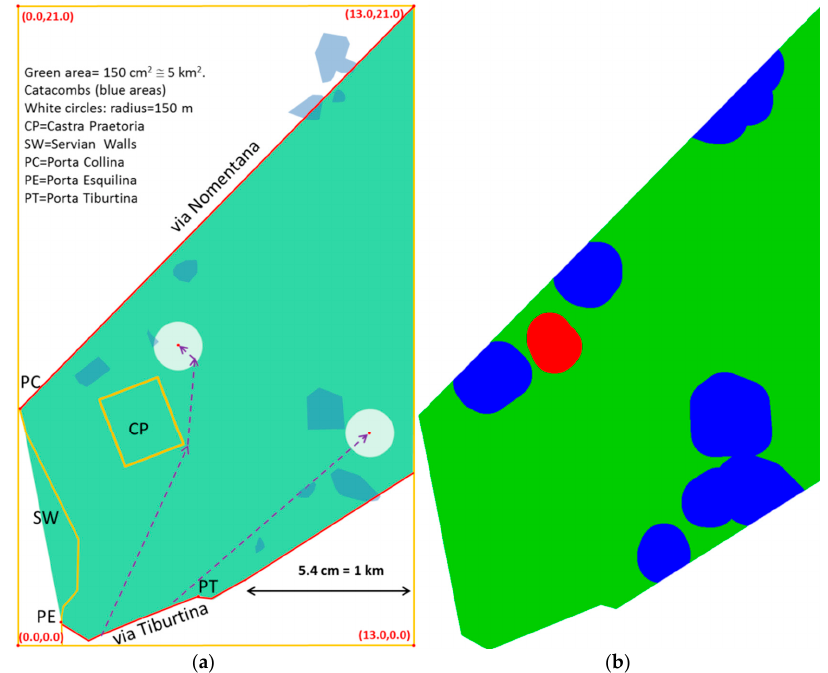
Figure 8. (( a ), left panel) Map of the (green) region between Via Tiburtina and Via Nomentana, with the extensions of the catacombs [66], represented in blue, necessary to calculate the geometric probability of intersecting a circle of radius 𝑅 (white) with a catacomb area (blue). Notice that the paths indicated are not taken into account by the geometric probability calculations, but have been drawn just for the purpose of illustration. (( b ), right panel) Example of the convolution product, Equation (2), obtainable with 𝑅 = 150 m. The result for the Anonymous Hypogeum is shown in red; the results for the other 9 catacombs are shown in blue.